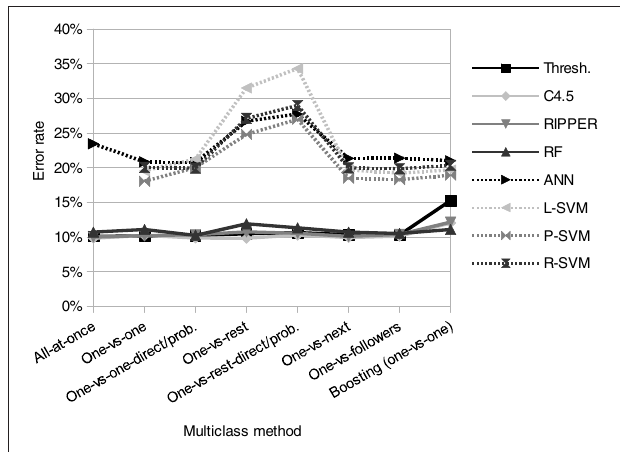
FIGURE 1 | Mean error values of learning algorithms and multiclass methods for all data sets.